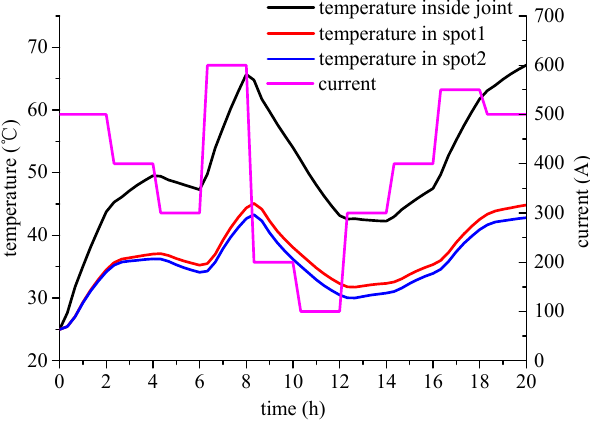
Figure 7. Transient temperature rise inside the joint and on the cable surface with variable loading.